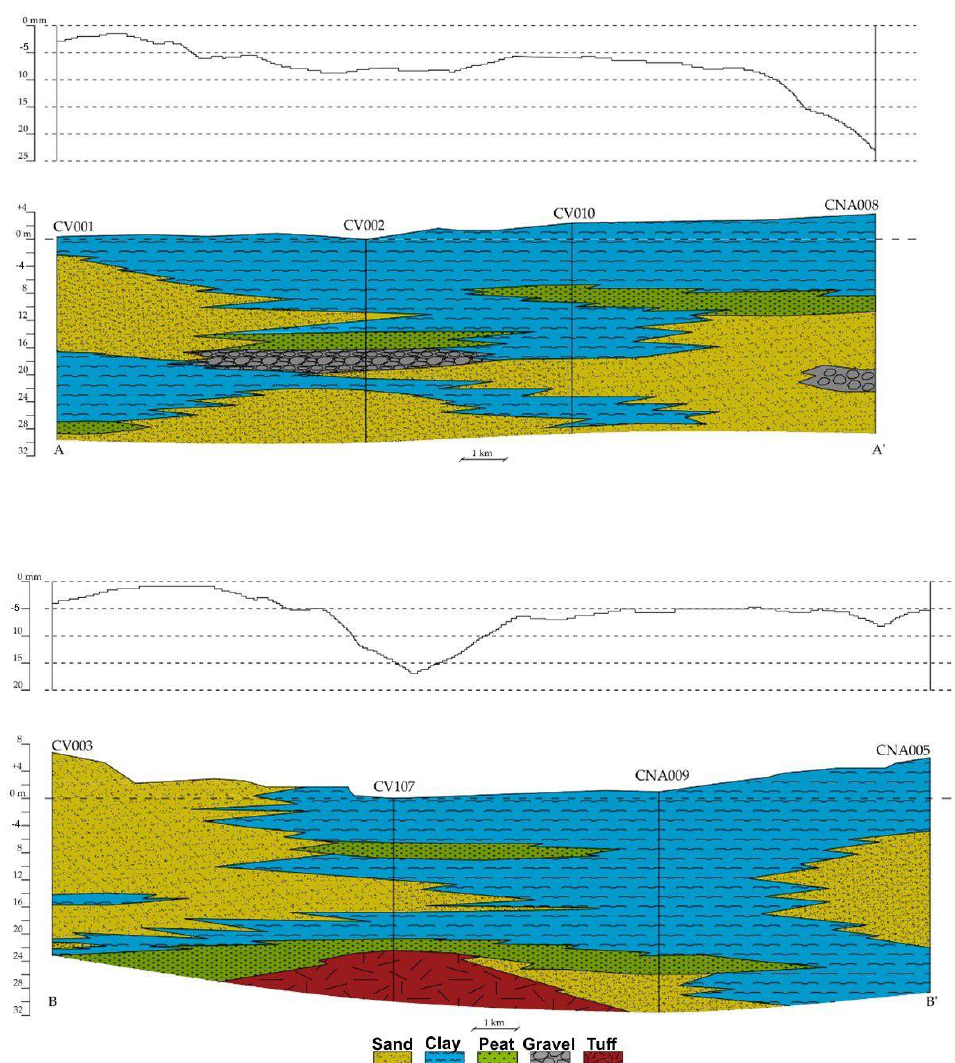
Figure 7. Sea–land lithological profiles compared with the vertical velocity of displacement detected by SAR data (track locations shown in Figure 6). Note the higher values corresponding to the major thicknesses of peat and clay lithologies. The two profiles refer to the Figure 6a for orientation (A–A1’,